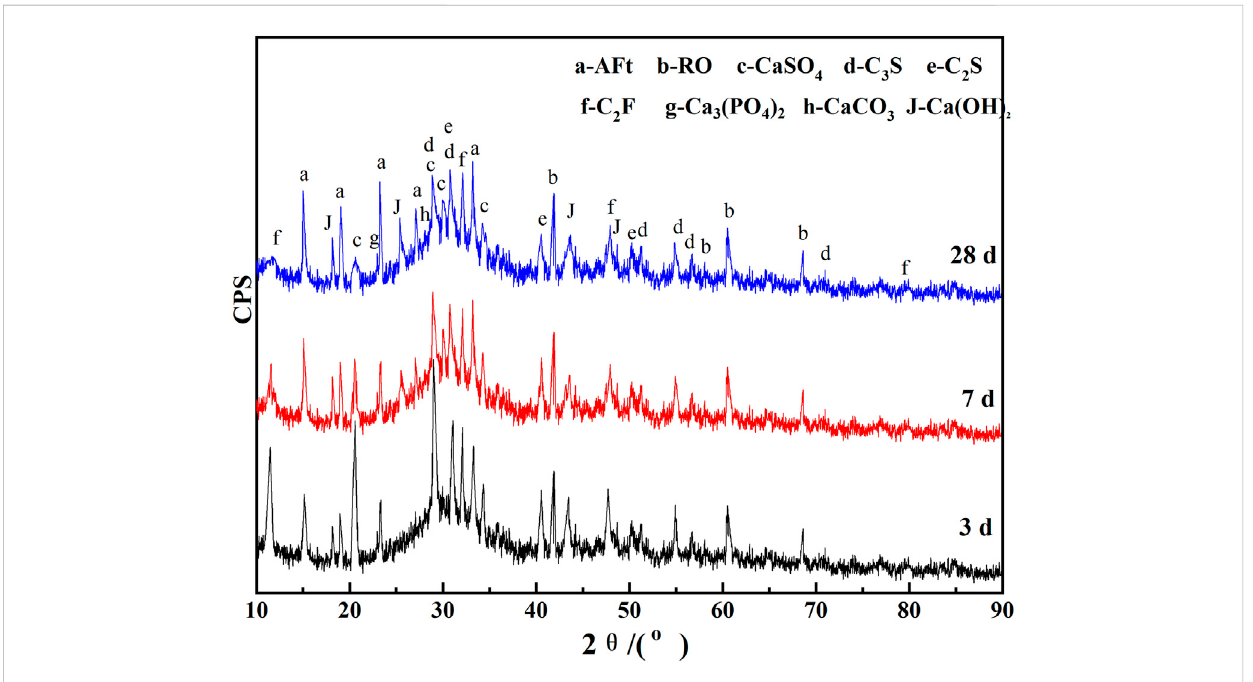
FIGURE 9 XRD pattern of CA paste samples at different